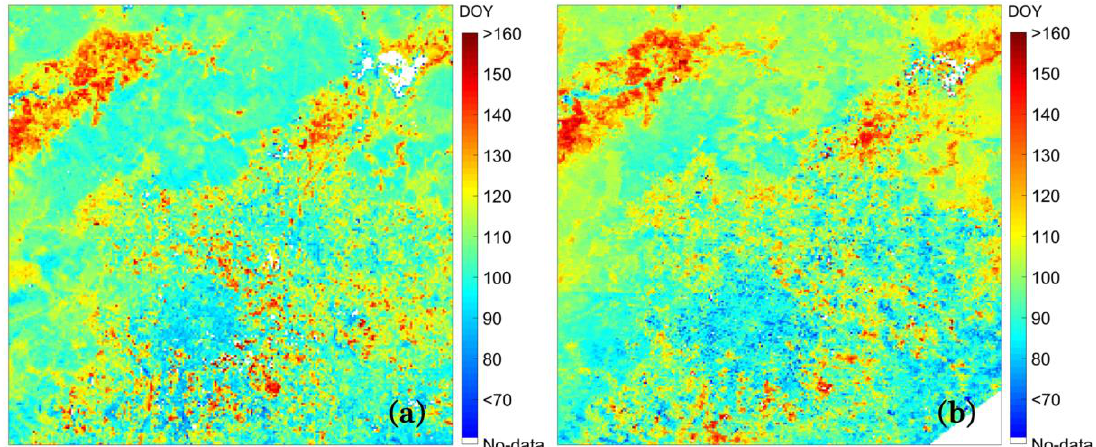
Figure 13. Comparison of vegetation spring phenology extracted from two different datasets: ( a ) resampled Sentinel-Landsat (500 m) and ( b ) MODIS (500 m).